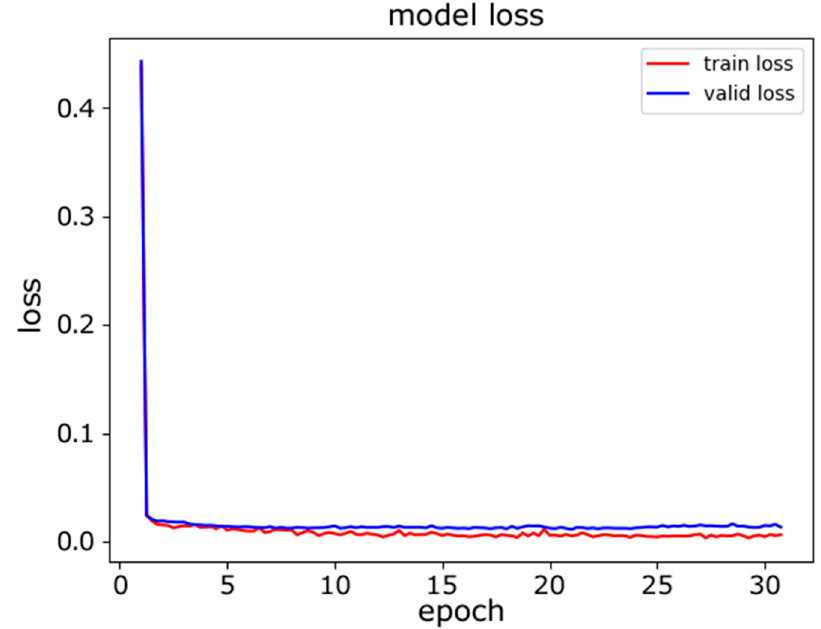
Figure 6. MLP model loss.